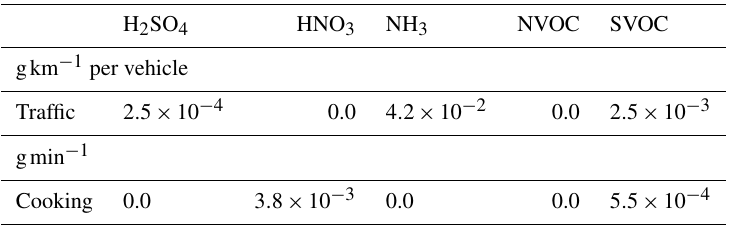
Table B2. Gaseous emission factors for cooking (Shen et al., 2018) and traffic (Kumar et al., 2008) emissions. In the latter case, the emission factors are derived by assuming that there is one stove for a kitchen of volume 16m 3 .